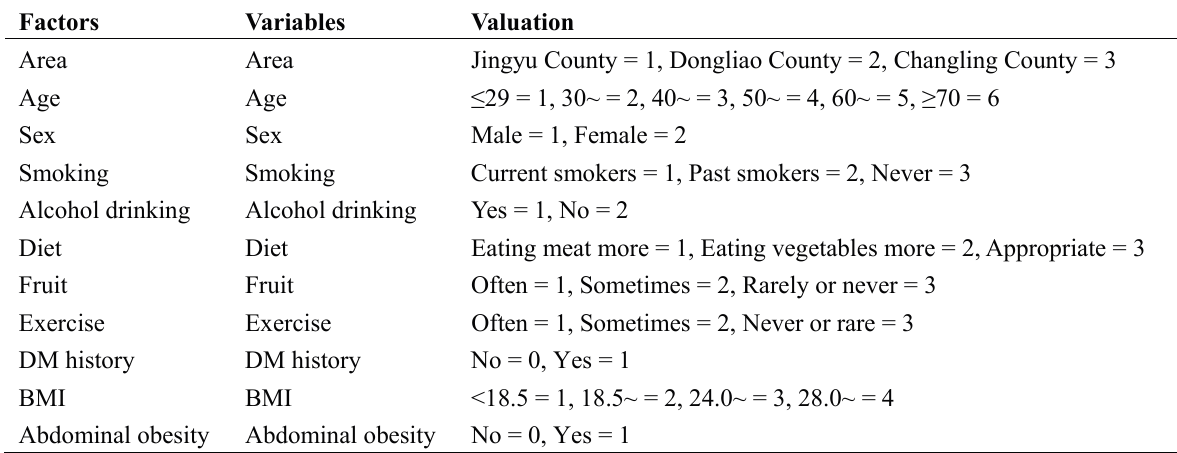
Table 1. The valuation of factors.